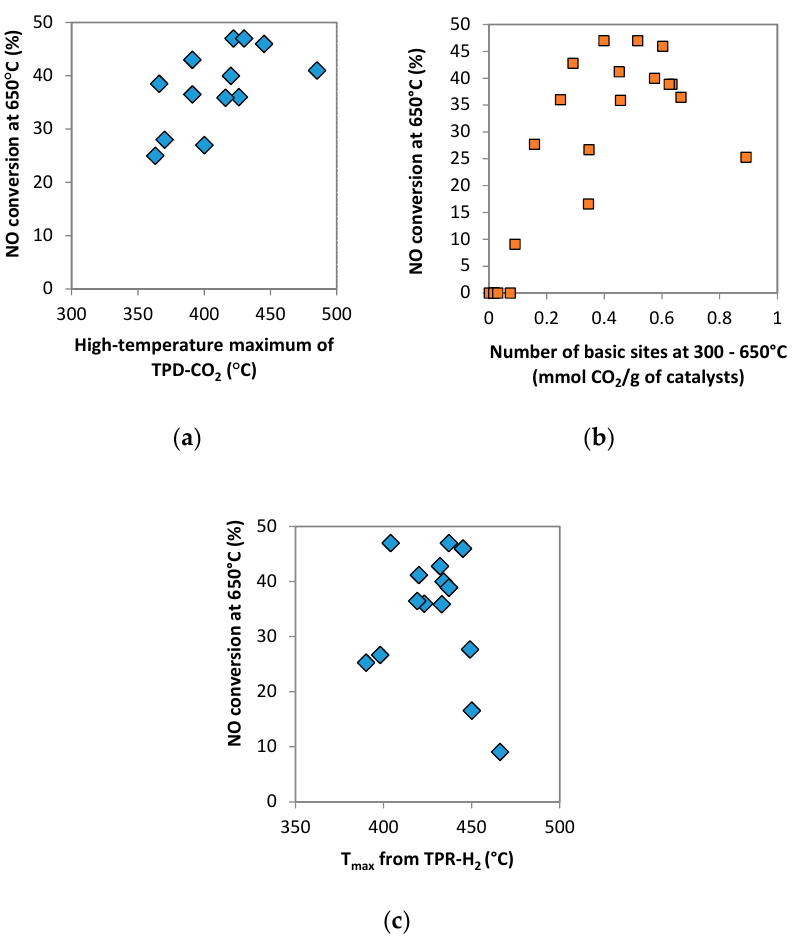
Figure 14. Dependence of NO conversion on: ( a ) the high-temperature maximum from TPD-CO 2 , ( b ) the number of basic sites, and ( c ) the temperature maximum from TPR-H 2 .